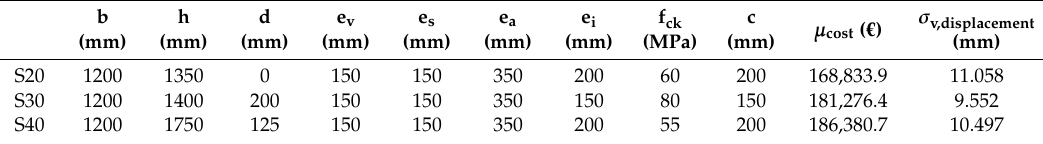
Table 10. Comparison of designs with the same structural behavior in prestressing force RDO problems.